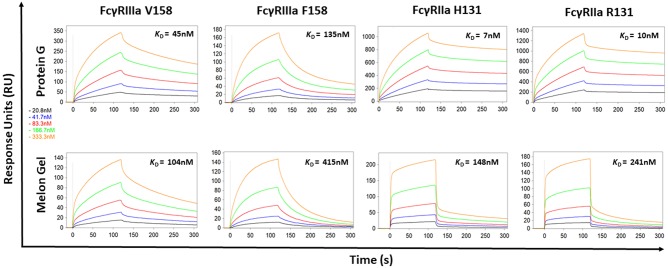
Binding kinetics of the high and low affinity variants of FcγRIIIa and FcγRIIa to IgG purified via Melon Gel and Protein G. Real-time surface plasmon resonance sensorgrams and affinity constants determined from SPR analysis representative of an individual polyclonal IgG sample serially diluted 2-fold from 333.3 nM.